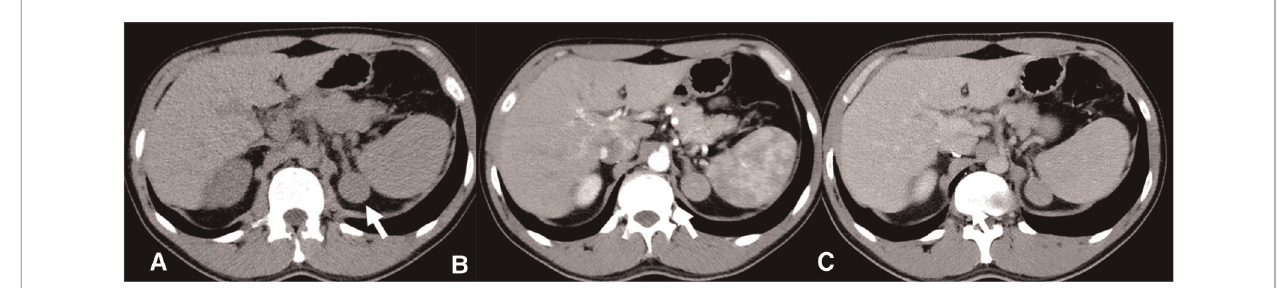
FIGURE 1 | CT scan 2018- Homogeneous left adrenal mass with regular margins, (arrow), diameter of about 3 cm and a non-contrast CT density greater than 10 HU ( A ) not indicative of the presence of lipids. In the arterial ( B ) and venous ( C ) contrast phases, the mass presents a slightly heterogeneous